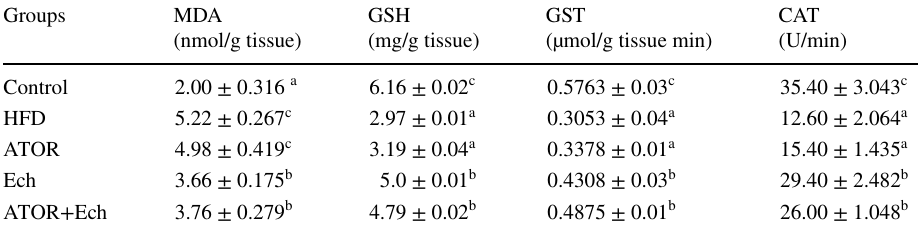
Table 4 Effect of Ech and ATOR on liver oxidative stress biomarkers in hyperlipidemic rats